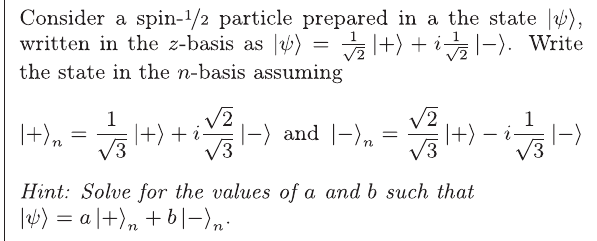
FIG. 4. One version of the quiz and exam change-of-basis question. Versions of this question were administered to students at each of the three institutions on several for-credit quizzes or exams in multiple semesters. Different versions of the question used different numerical coefficients and/or used varied language for the hint.